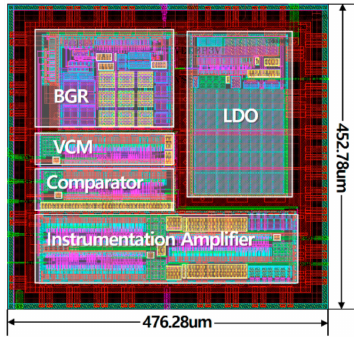
Figure 4. 2D layout drawing of the 0.18- µ m CMOS process-based